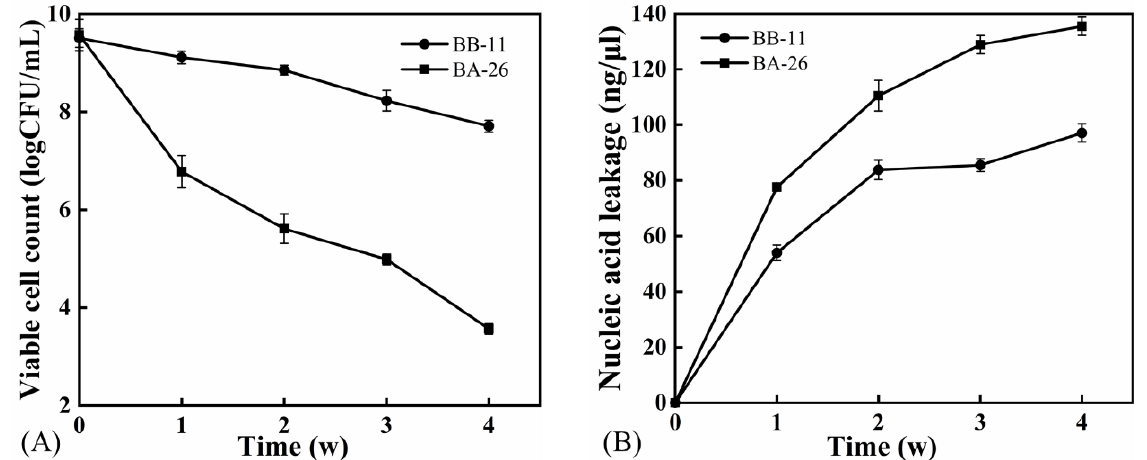
Figure 1. Viable cell number growing on TSA-YE plates ( A ) and intracellular nucleic acid leakage; ( B ) of S. aureus after low temperature (4 ◦ C) treatment. Error bars represent standard deviations ( n = 3).